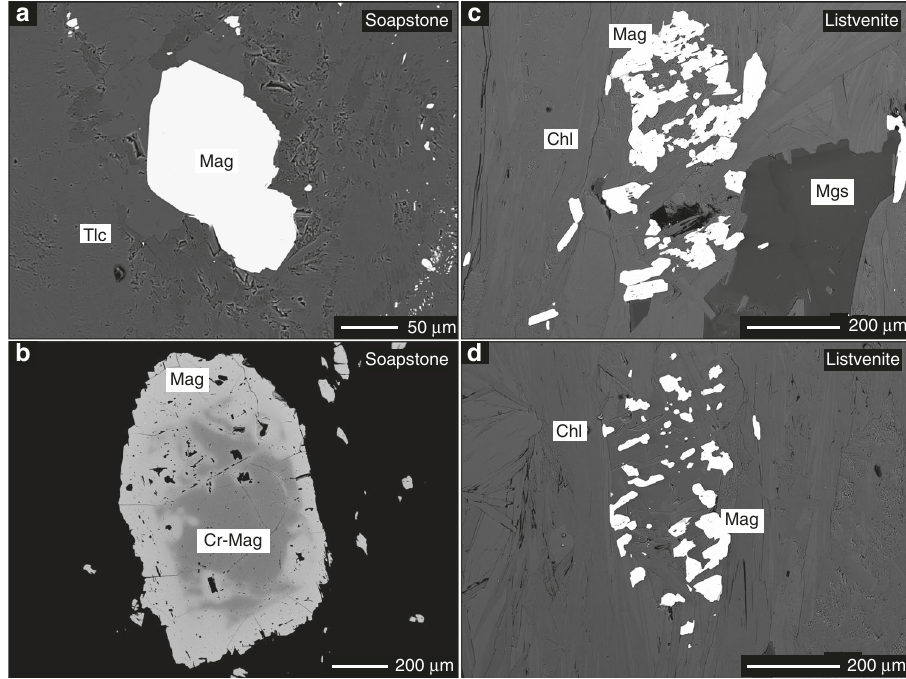
Fig. 8 Reaction textures of magnetic carrier minerals. BSE images showing a comparison of magnetite textures between soapstone a and b and listvenite c and d . Magnetite in the soapstone is coarse grained and exhibits a subhedral crystal shape. In contrast, magnetite in the listvenite is usually fi ne grained with individual grains forming clusters that outline the size and shape of magnetite in the soapstone. Soapstone magnetite typically contains a chromium – bearing magnetite (Cr – Mag) core b